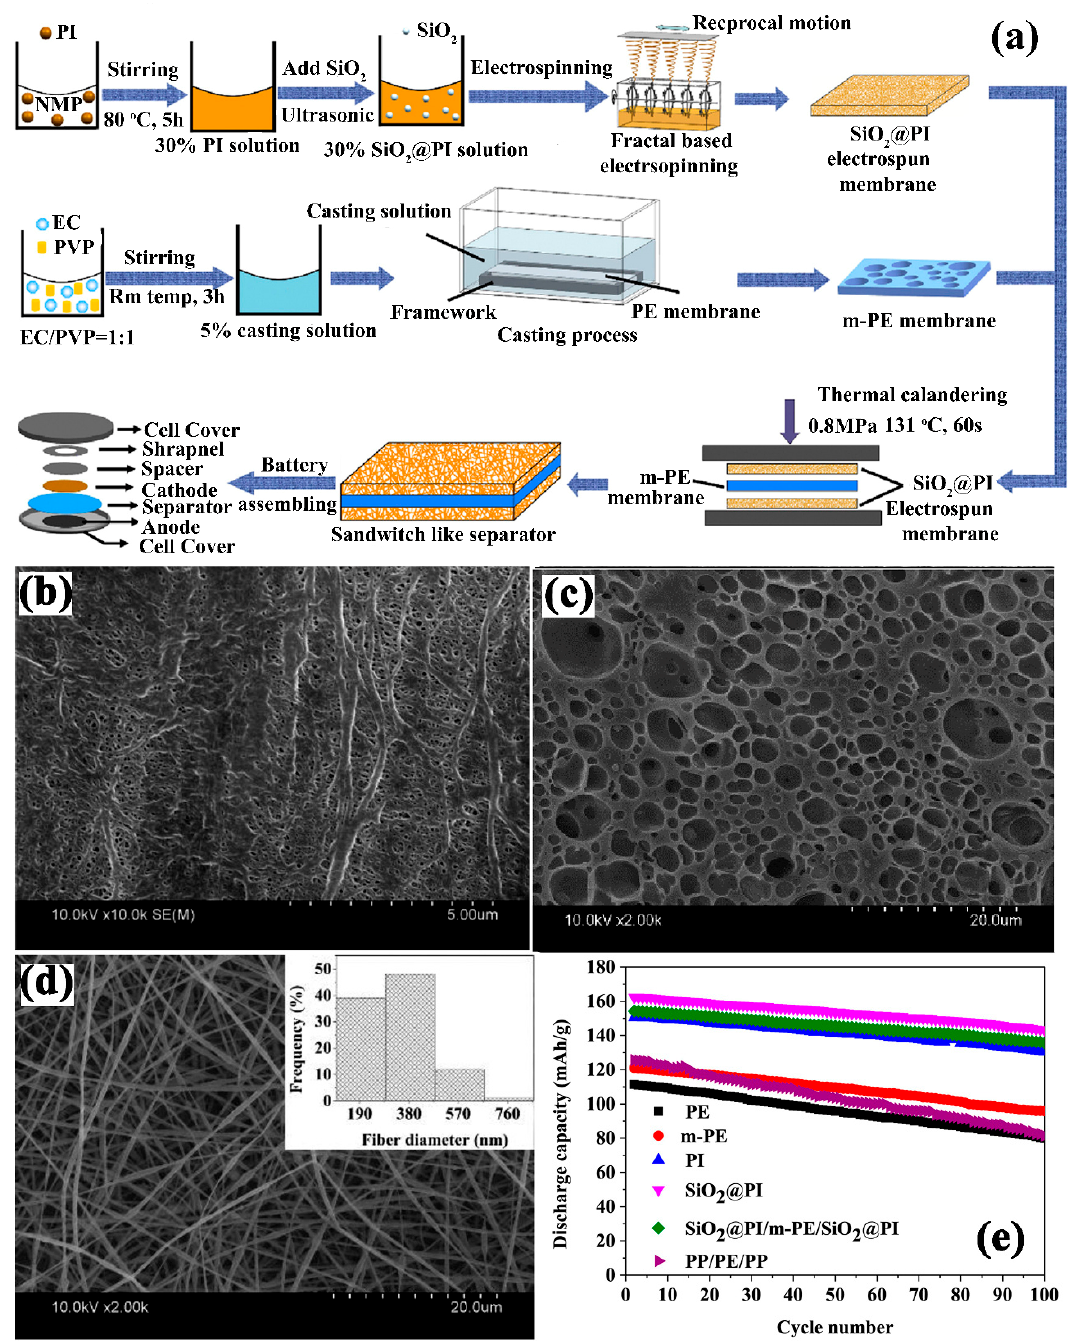
Figure 7. ( a ) The schematic diagram of composite separator preparation and battery assembly process SEM view of ( b ) PE membrane, ( c ) m-PE membrane ( d ) SiO 2 @PI containing 2% SiO 2 ( e ) discharge capacities of different separators at 0.2 C rate [125], with copyright permission from Elsevier.